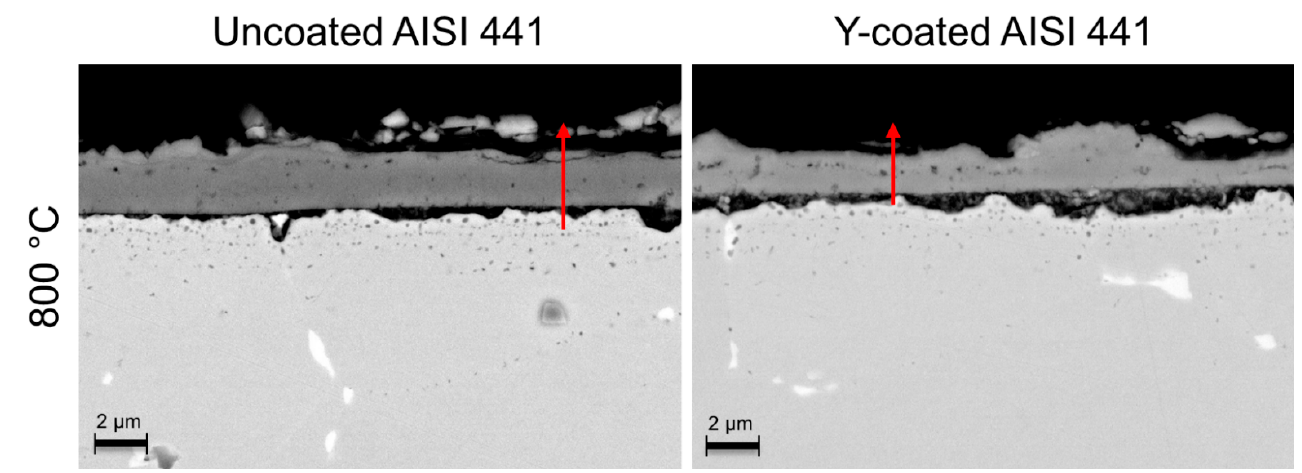
Figure 14. Uncoated AISI 441 ( left ) and Y-coated AISI 441 ( right ) after 1500 h at 800 °C in reducing atmosphere. The red line indicates the place of profiles shown in Figure 15.